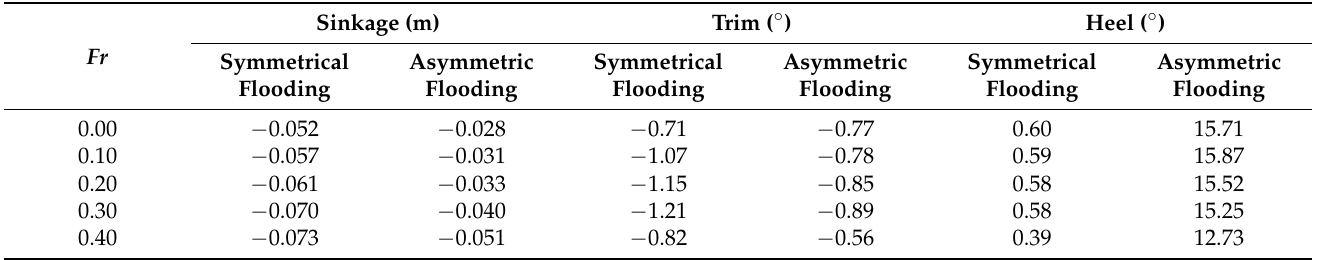
Table 12. The comparison of ship attitudes under symmetrical flooding and asymmetric